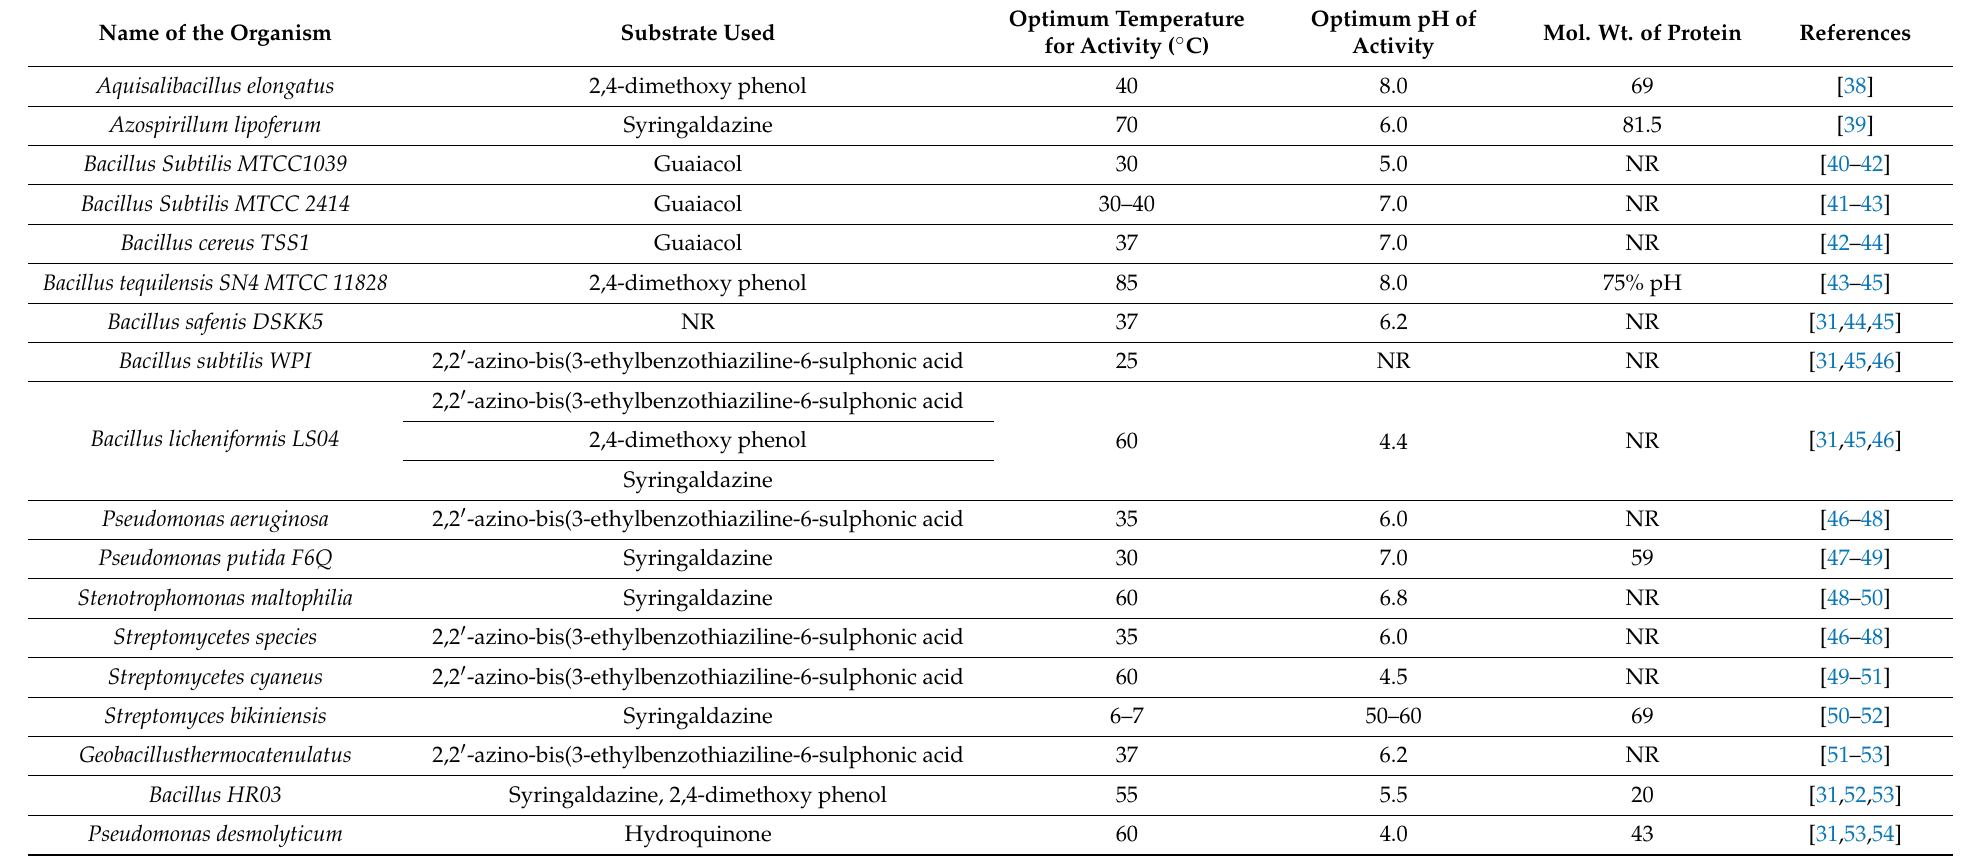
Table 1. Production conditions and